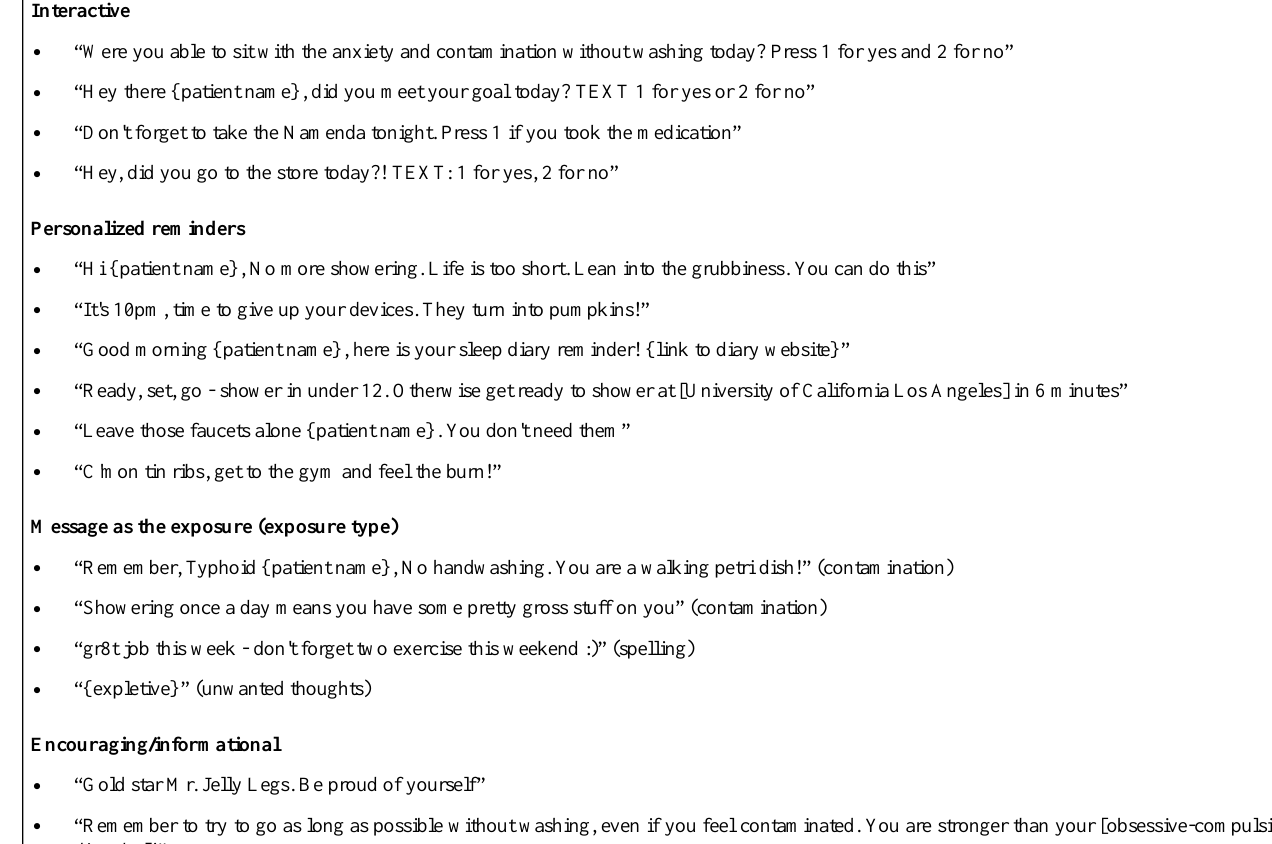
Textbox 1. Content of mobile texting